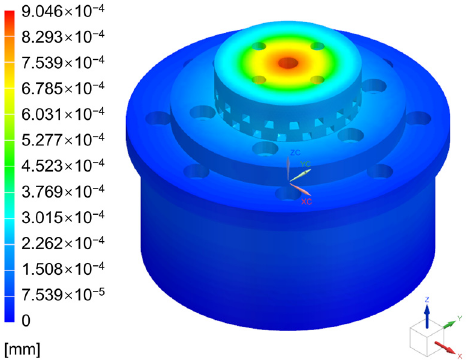
Figure 7. Deformation contour of the model under four loads.